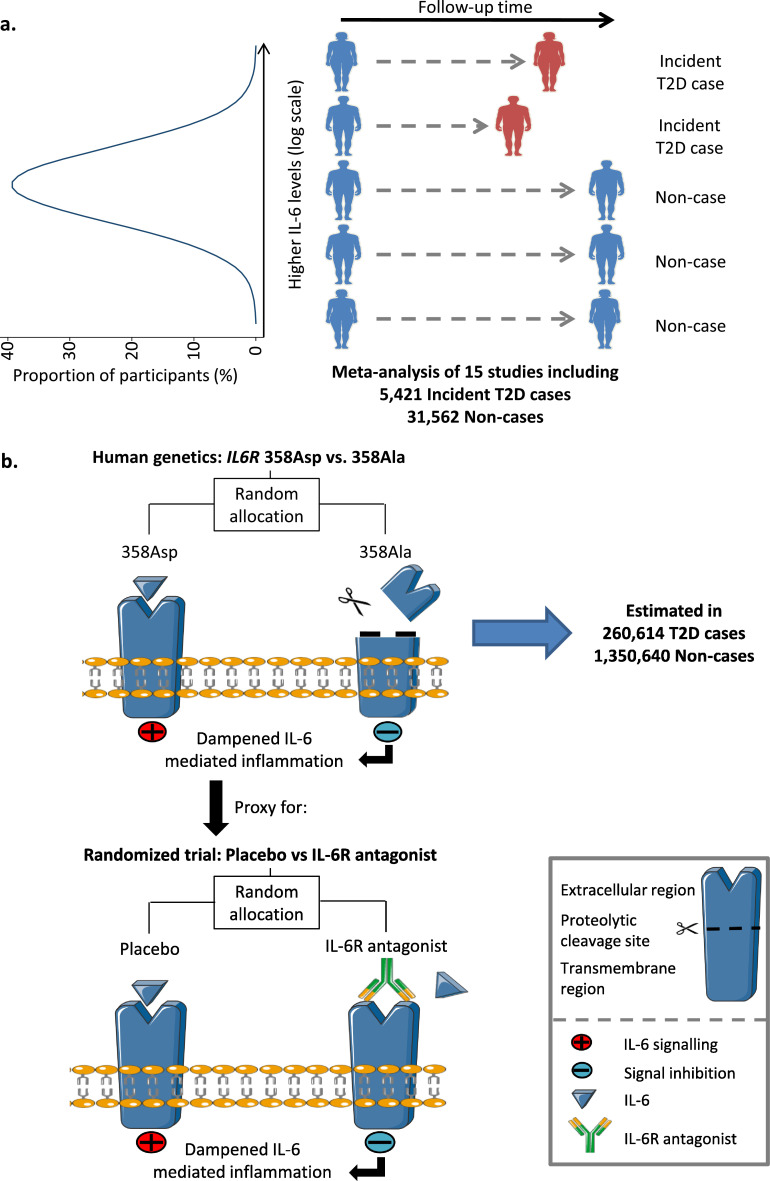
Study design. Panel a. Prospective association between IL-6 levels and risk of incident type 2 diabetes. Panel b. Mechanism by which IL6R Asp358Ala leads to dampened IL-6 mediated inflammation. Asp358Ala increases the proteolytic cleavage of the IL-6R, depicted with a pair of scissors, resulting in dampened classical IL-6 signaling. This is similar to the effects of an IL-6R antagonist, shown at the bottom of the panel. Abbreviations: T2D, type 2 diabetes; IL-6, interleukin-6; IL-6R, interleukin 6 receptor (protein); Asp, aspartic acid; Ala, alanine; gp130, Glycoprotein 130.Modified from Servier Medical Art, licensed under a Creative Commons Attribution 3·0 Generic License from http://smart·servier·com.